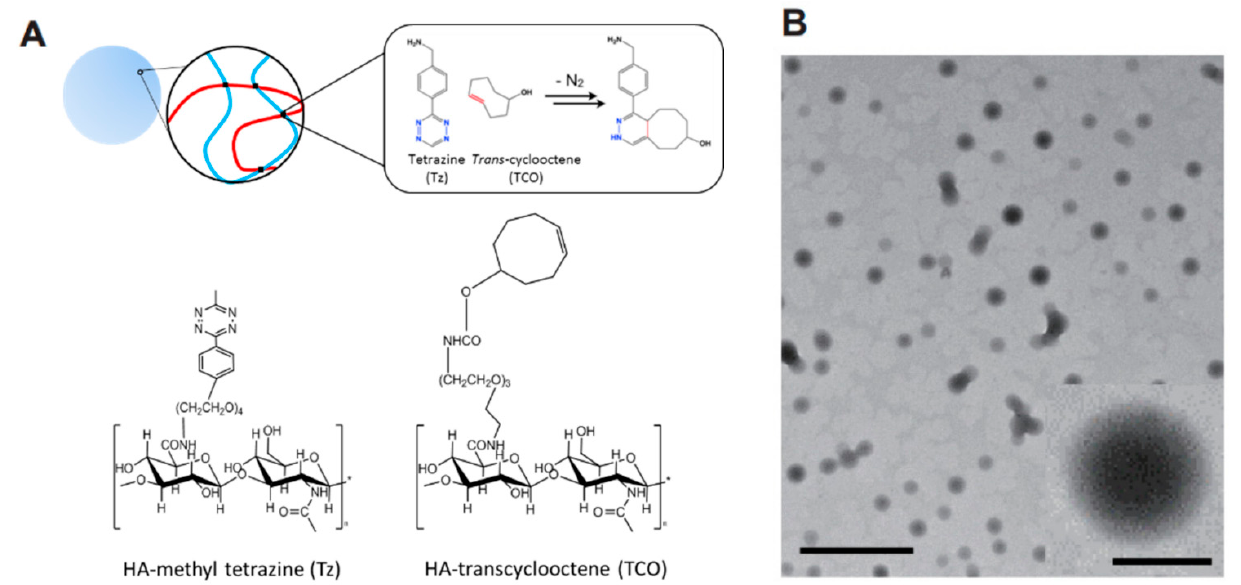
Figure 2. ( A ) Schematic representation of HA nanogels crosslinked by methyl tetrazine (Tz) and trans-cyclooctene via click chemistry (TCO). ( B ) HA nanogel Cryo-TEM picture (scale bar = 500 nm) [34].